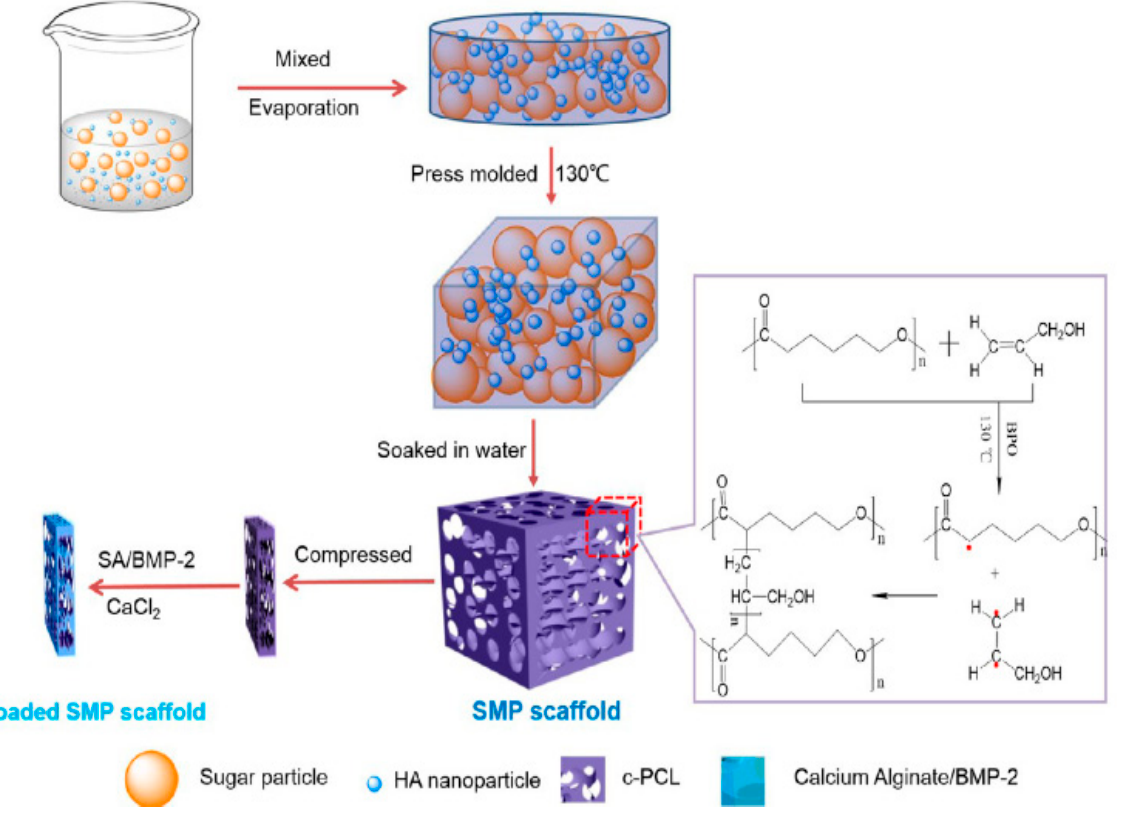
Figure 4. Smart biomaterial with shape memory for periodontal regeneration. “Reprinted (adapted) with permission from Ref. [132]. Copyright 2014 American Chemical